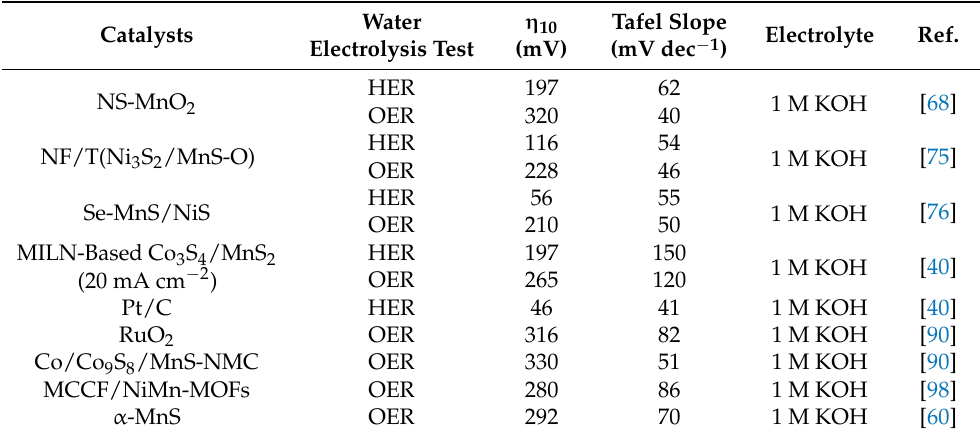
Table 1. Summary table of electrocatalytic performance of manganese-based electrocatalysts in HER and OER. η Water Catalysts Electrolysis Test